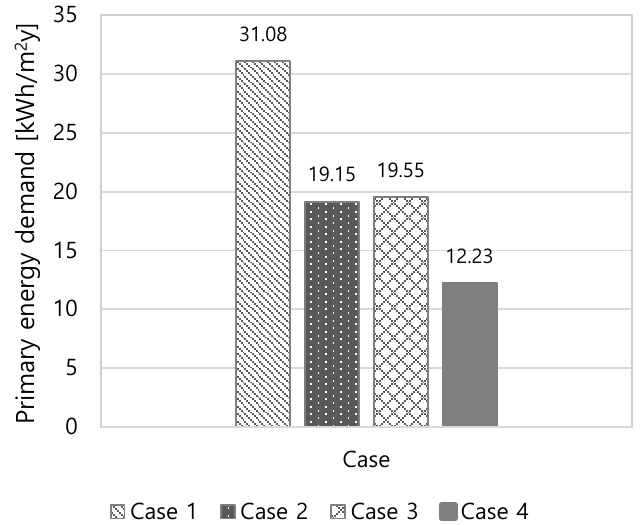
Figure 8. Primary energy demand of each case.